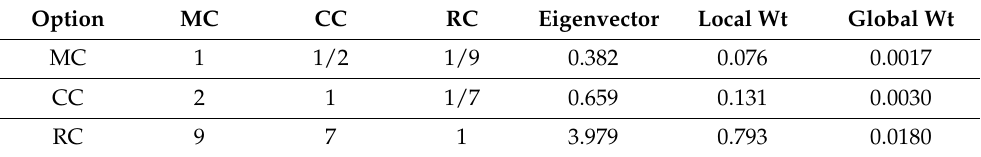
Table A19. Comparison of alternatives matrix for subcriterion EN3.